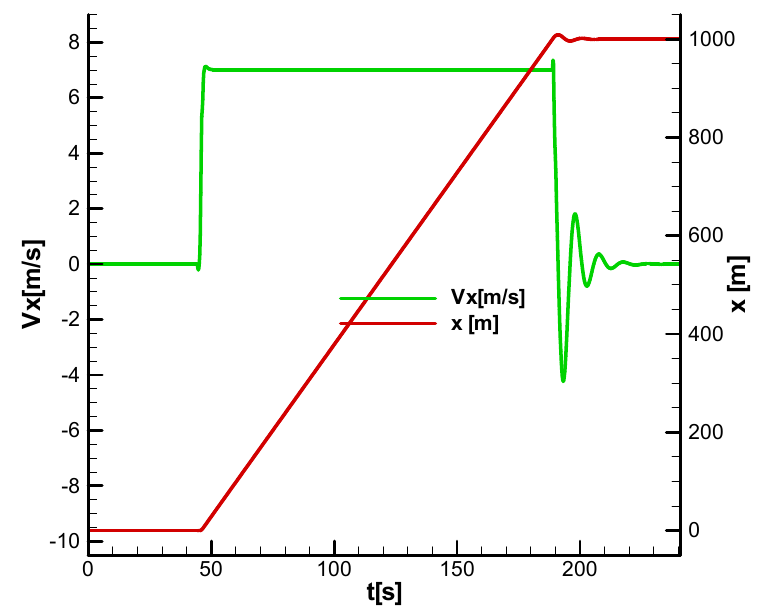
Figure 20. Horizontal velocity and horizontal coordinate.